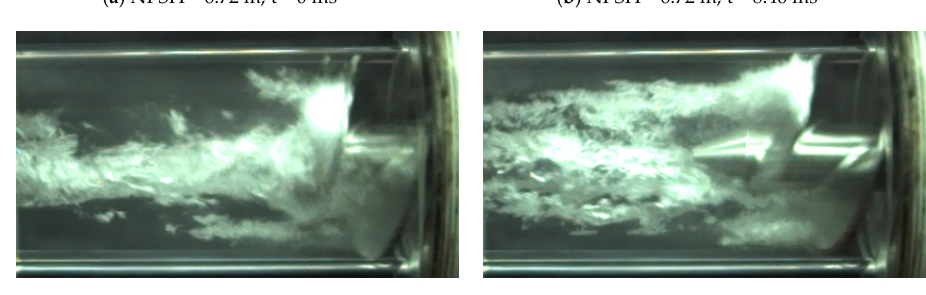
Figure 13. Cavitation performance curve of a high-speed magnetic pump. 6. Conclusions Visual experiments of a high-speed inducer magnetic drive pump operating at n = 8000 r/min were conducted. The cavitation evolution of the inducer under different con- ditions were captured. The following conclusions are drawn: 1.